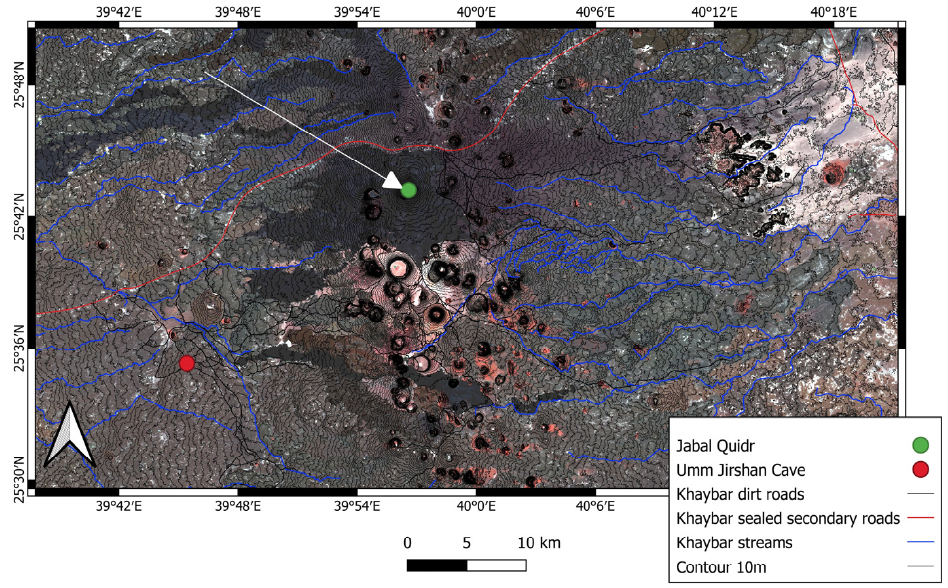
Figure 6. SWIR Sentinel satellite image showing the young lava flows clearly (dark) and their separation from pyroclast-filled zones (pinkish). The arrow points to Jabal Quidr.